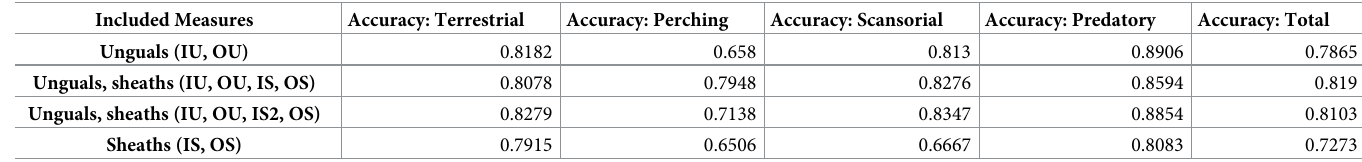
For the model based solely on two ungual bone measurements (Fig 4), two axes LD1 and LD2 are generated that account for all variation. For the model utilising four measurements (Fig 4), LD1 and LD2 account for 97% of the variation, and so LD3 is not likely to significantly impact separation. LD1 represents greater or lesser values of claw angle for any given metric, accounts for greater than 85% of variation, and separates terrestrial taxa from predatory/perch- ing taxa from scansorial taxa. Claws of perching birds tended to have lower LD2 values com- pared to claws of predatory birds. Despite differing centroids (Table 2), there is overlap between ranges for each group. Mor- phospaces created based on measures of avian ungual bones overlap between all categories except ‘terrestrial’ and ‘scansorial’. Those based on all claw measures have similar degrees of overlap but manage to also separate ‘terrestrial’ and ‘predatory’ groups. Centroids of inner and outer curvatures for ungual bones differed between all behavioural categories except the ‘perching’ and ‘predatory’ categories (Table 2). This is not unexpected as box plots shows inner and outer curvature values of the ‘predatory’ group completely overlap with ranges found for the ‘perching’ group (Fig 4). Pairing inner and outer curvatures of the ungual bone makes it possible to distinguish between perching and predatory claws; centroids based on these values differed significantly between all groups. Interestingly, including soft tis- sue measures in the multivariate analysis worsened separation among groups. Centroids based on four measures of sheath and ungual curvatures differed significantly between all groups except for perching and predatory taxa, the comparison of which yielded a p-value equal to 0.0736 after Bonferroni correction. bird claws (total accuracy = 0.7865) relative to models based on similar measures taken on keratinous sheaths (total accuracy = 0.7273). Both predictive models based on bone and sheath measurements had relatively greater success than models based on only two measures (Table 3). Utilising the modified sheath measure IS2 as opposed to IS slightly reduced predic- tive success (total accuracy = 0.8103) but did not greatly alter results relative to the model uti- lising IU, OU, IS, and OS (total accuracy = 0.8190). Table 3. Predictive success of the models based on extant bird claws. Accuracy for each behavioural category and weighted total accuracy are listed. Included Measures Accuracy: Terrestrial